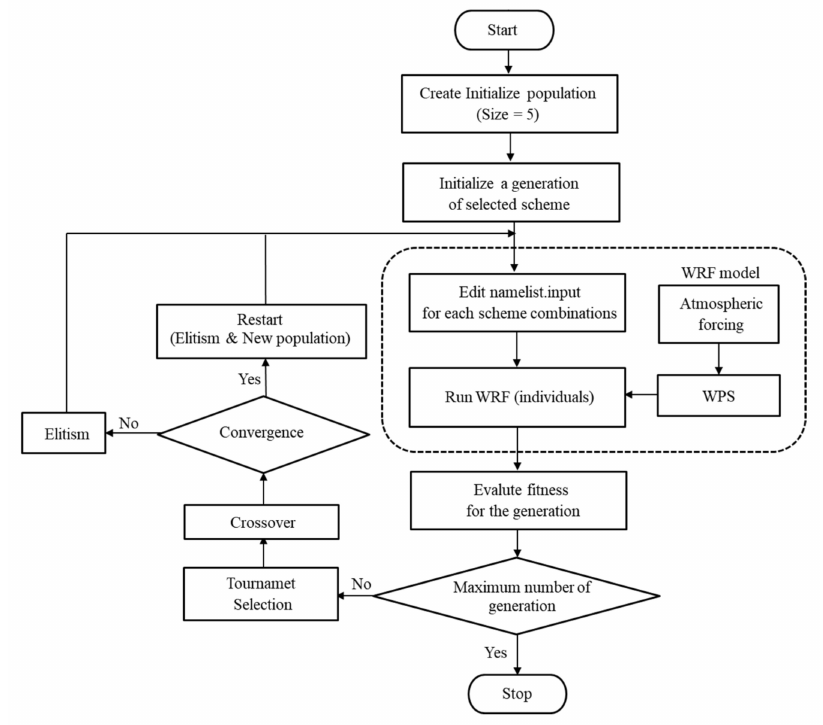
Figure 3. The flow chart describing the combinational optimization process from the WRF- µ GA